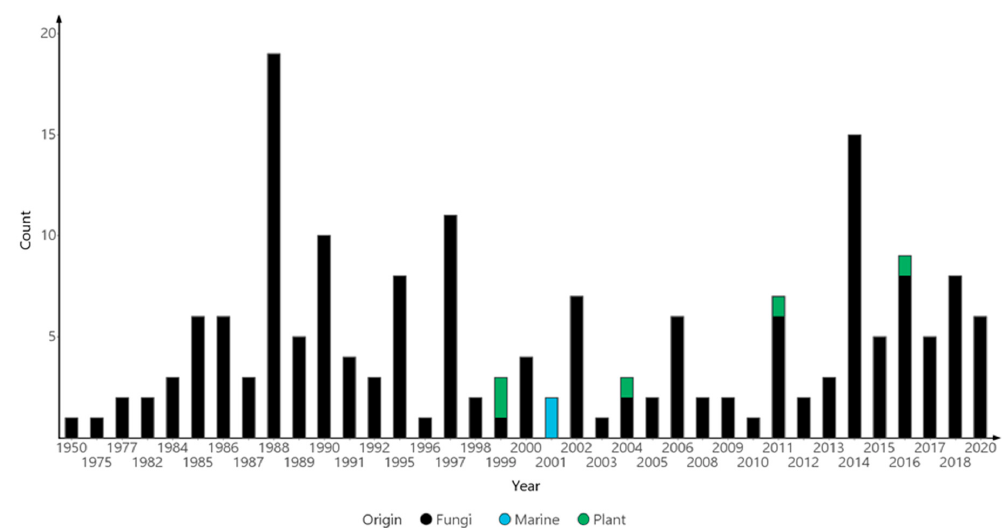
Figure 2. Timeline of the discovery of protoilludane natural products from marine, plant and fungal sources.